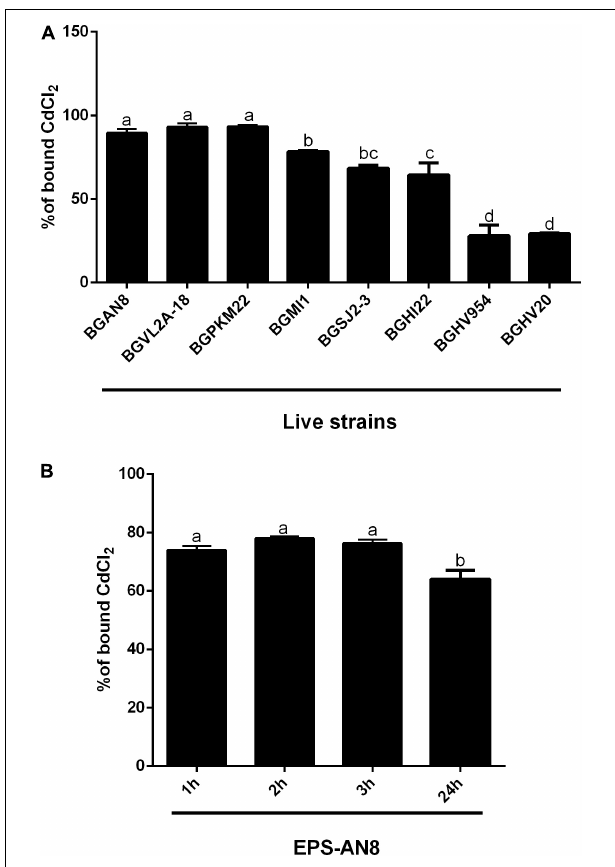
FIGURE 1 | Ability of live exopolysaccharide (EPS)–producing lactobacillus strains to bind Cd (A) and ability of EPS isolated from the selected Lactiplantibacillus plantarum AN8 strain (EPS-AN8) to adsorb Cd ions after 1, 2, 3, and 24 h of exposure (B) . Values that do not share a common letter are significantly ( p < 0.05)